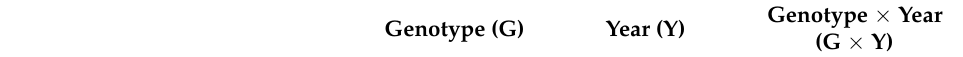
Table 4. Two-way ANOVA performed on: (i) SIMPER-selected compounds; (ii) all detected chemical classes; (iii) EO extraction